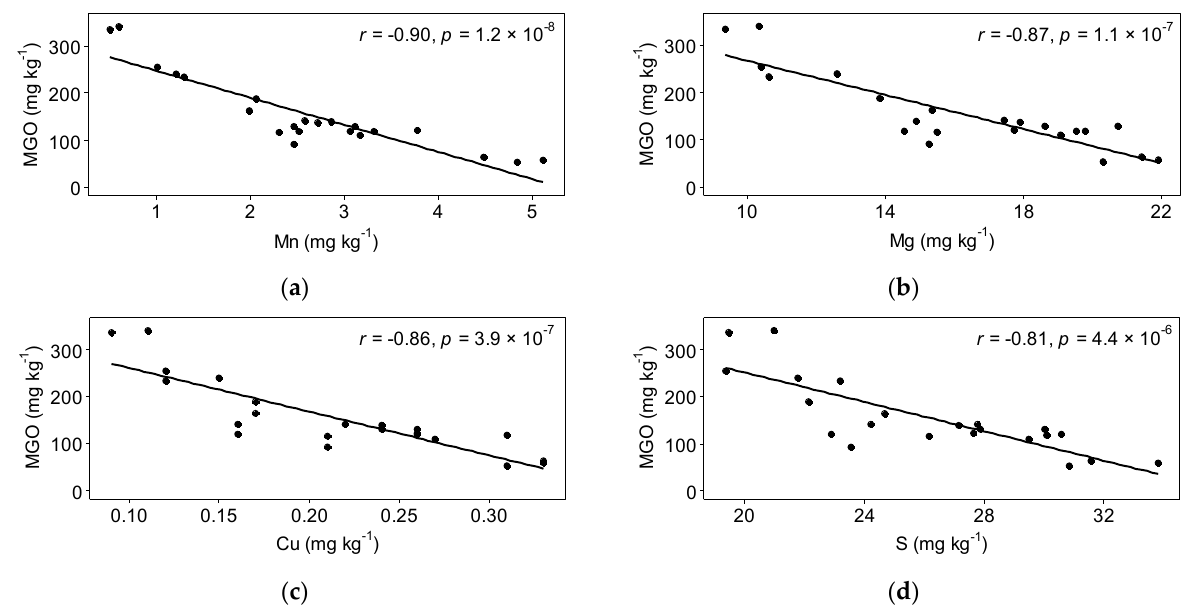
Figure 3. Honey MGO versus honey elemental concentrations: ( a ) Mn; ( b ) Mg; ( c ) Cu; ( d ) S. The black lines are linear regression lines. R values are Pearson’s correlation coefficients.